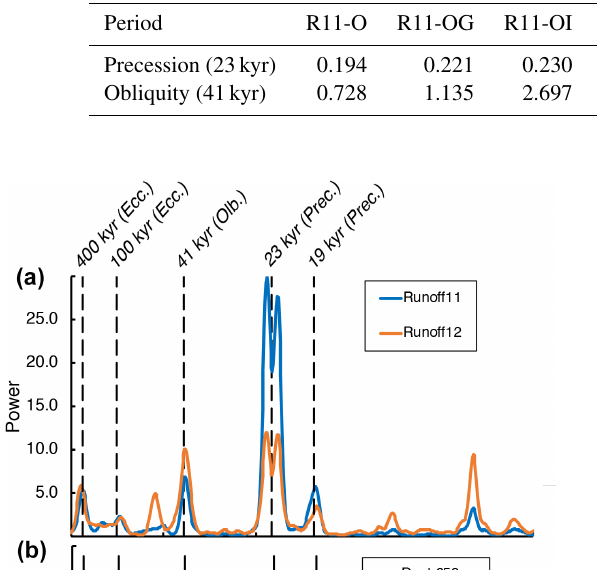
Table 1. Calculated time lags in thousands of years (kyr) between orbital frequencies and runoff over grid boxes 11 and 12 for the full period 3.2 to 2.3Ma. Frequencies are extracted from the data with a Gaussian filter for precession at 23kyr (0.0435 ± 0.003) and for obliquity at 41kyr (0.0245 ± 0.003). Data were analysed with AnalySeries (Paillard et al., 1996) using a Blackman–Tukey spectral analysis with a Parzen window and 90% lags. CLIMBER-2 experiments are as follows. O: orbital; OG: orbital and CO 2 ; OI: orbital and ice sheets; OIG: orbital, CO 2 , and ice sheets.